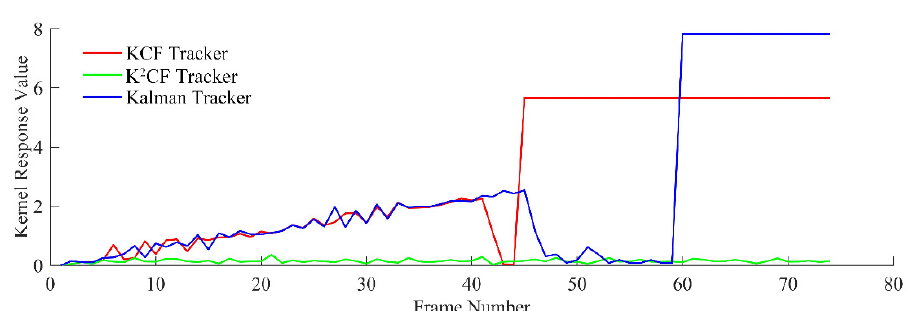
Figure 15. Output detection value of uniform acceleration state.